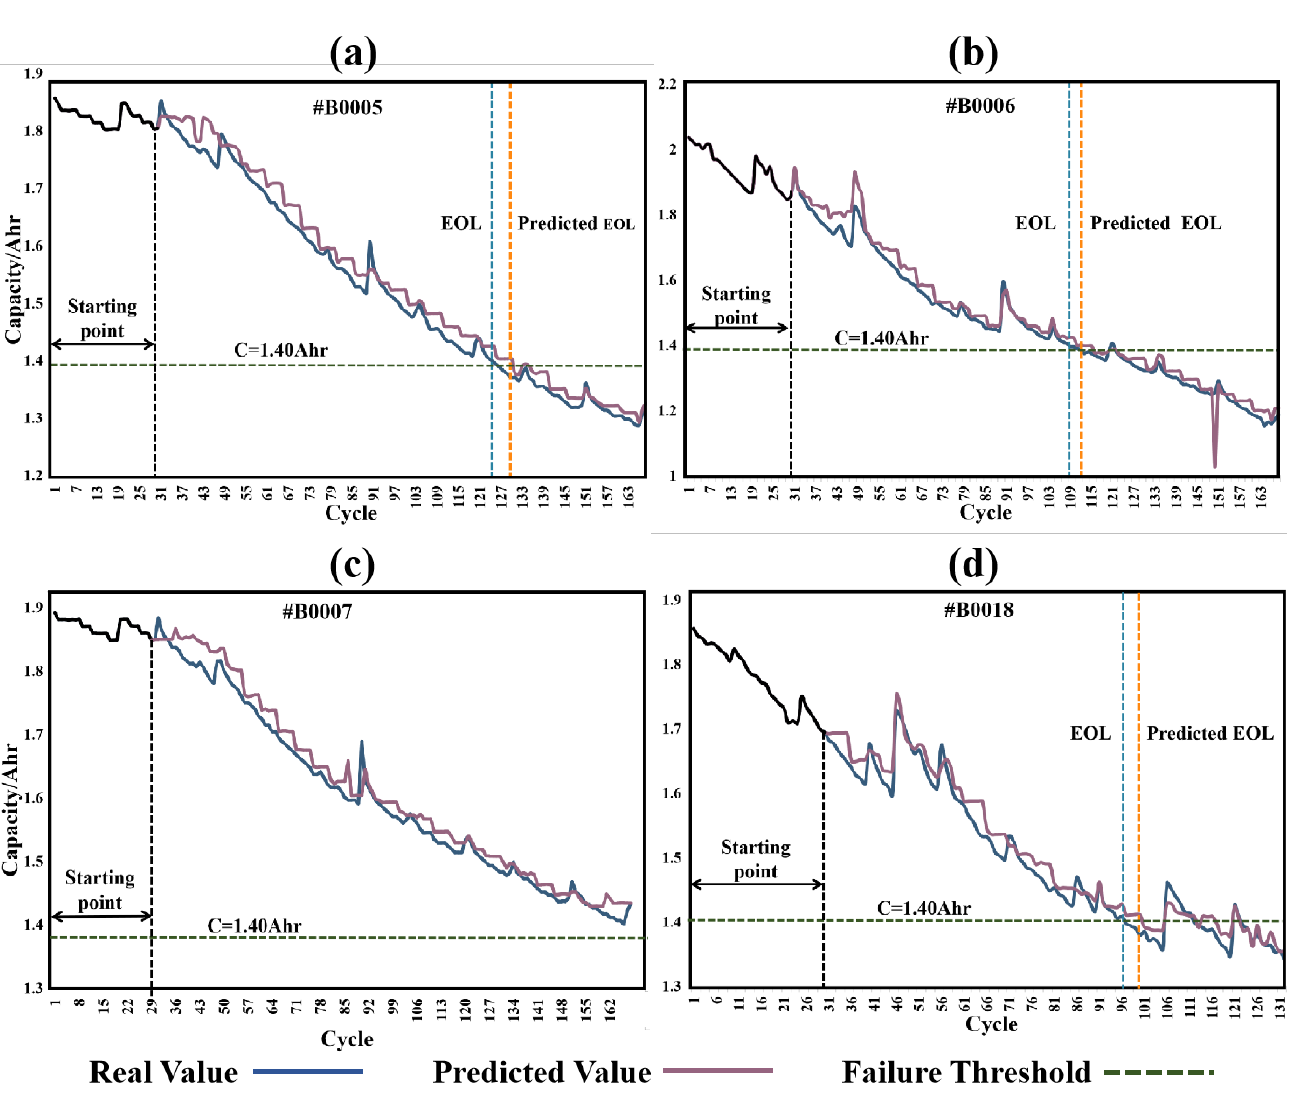
Figure 4. The DSR model’s predicted results and real decay trajectories with the increase in cycles for batteries #5 ( a ), #6 ( b ), #7 ( c ), and #18 ( d ), discharged at 2A and 24 °C, respectively.